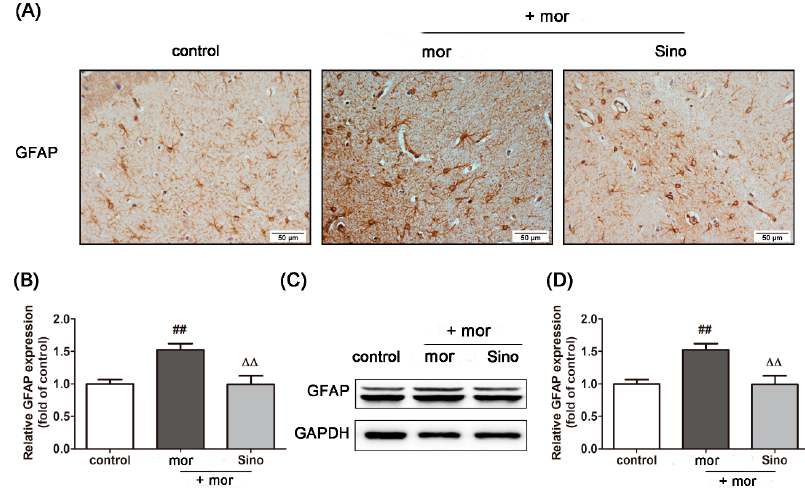
Figure 4. Sinomenine inhibited the activation of morphine-treated astrocytes. ( A , B ) Immunohistochemistry analysis was used to quantify the expression level of GFAP in the hippocampus of morphine-dependent mice ( n = 3); ( C , D ) Western blotting analysis was used to quantify the expression level of GFAP in cultured primary astrocytes ( n = 3). Cultured primary astrocytes were pretreated with phosphate buffer saline (PBS) or 200 μ M sinomenine for 12 h and then incubated with 100 μ M morphine for 48 h. ## p < 0.01 vs. control; ΔΔ p < 0.01 vs. morphine.